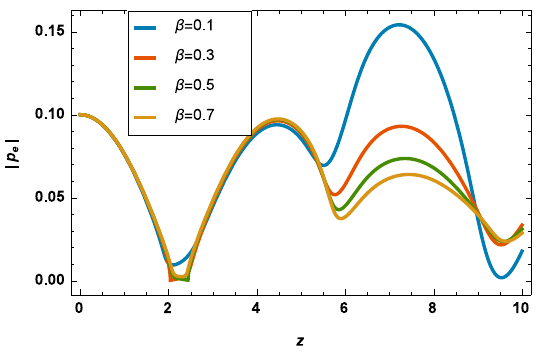
Fig. 12 Pressure along Constricted Tube for Various Values of β with λ a = 0 . 5 , α =